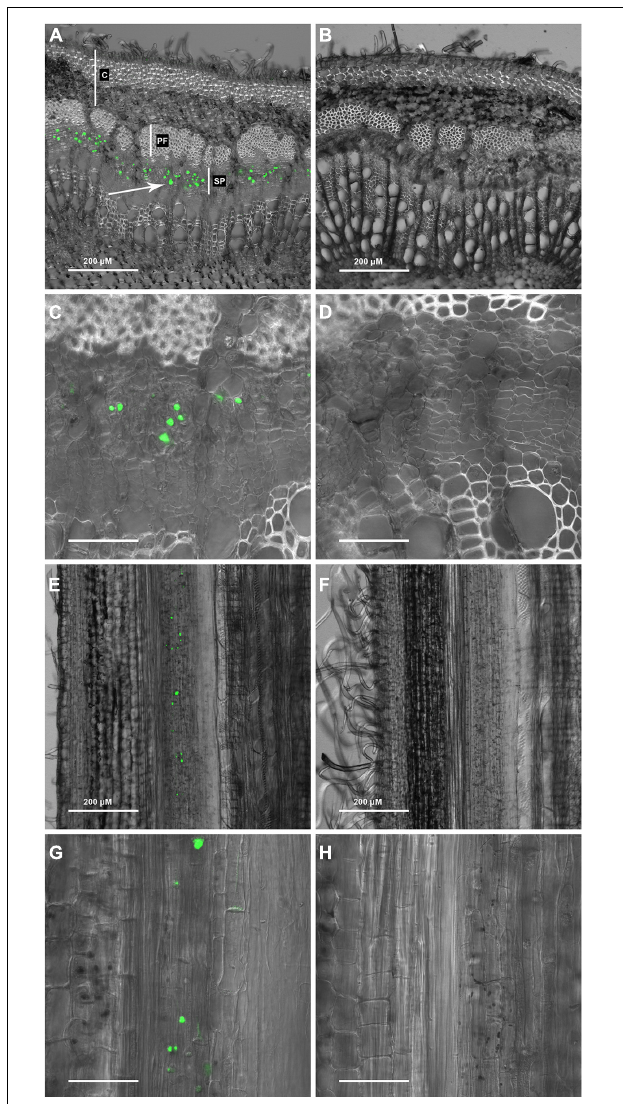
FIGURE 1 | OGA 488 labeling of P-proteins (arrows) in P. tremula × P. alba (717) transverse stem sections. (A) 717 stem transverse section labeled with OGA 488 C, cortex; PF, phloem fibers; SP, secondary phloem. (B) 717 stem transverse section with no probe (control). (C) 717 stem transverse section labeled with OGA 488 . (D) 717 stem transverse section with no probe (control). (E) 717 stem longitudinal section labeled with OGA 488 . (F) 717 stem longitudinal section with no probe (control). (G) 717 stem longitudinal section labeled with OGA 488 . (H) 717 stem longitudinal section with no probe (control). Scale bars: (C,D,G,H) = 50 µ m.